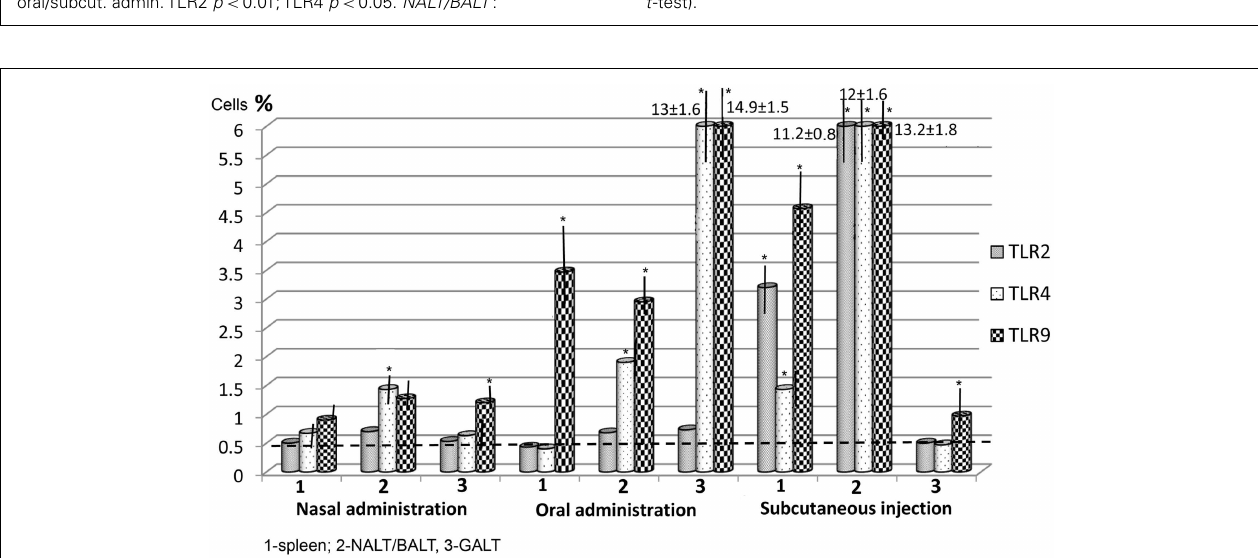
FIGURE 1 |The level ofToll-like receptors (TLRs) by route of vaccine administration, after one application .The stippled line indicates the maximum levels ofTLR expression in control (non-immunized) mice ( n = 10 in each group). Spleen : nasal/oral admin.TLR2,3,9 p > 0.05; nasal/subcut. admin.TLR2 p < 0.01;TLR4 p < 0.05;TLR9 > 0.05, oral/subcut. admin.TLR2 p < 0.01;TLR4 p < 0.05. NALT/BALT :